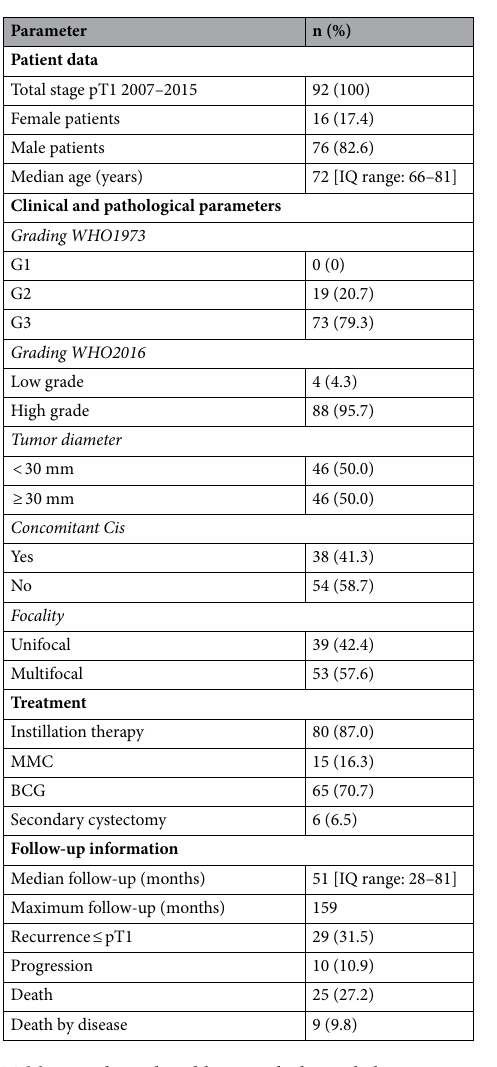
Table 1. Clinical and histopathological characteristics of the pT1 NMIBC cohort with the bladder-sparing approach.